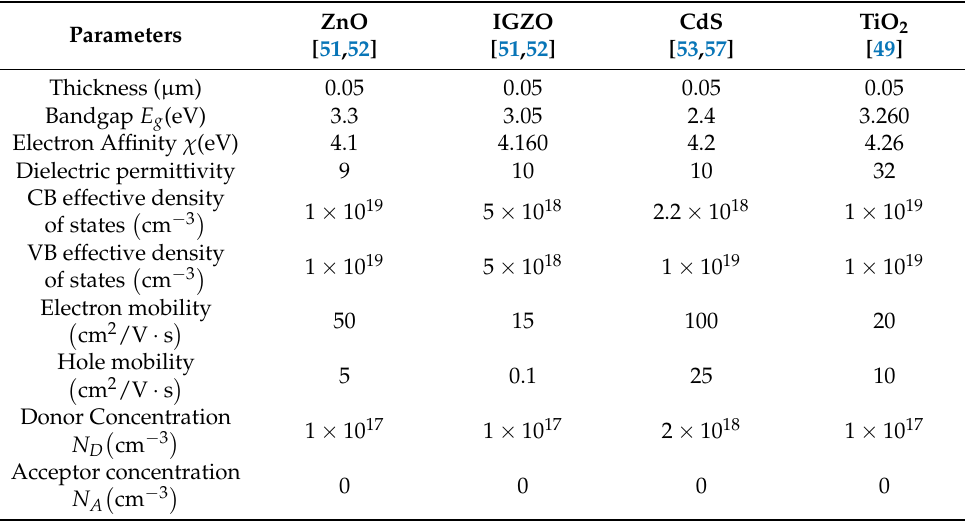
Table 2. Electrical and optical properties of different ETL materials.